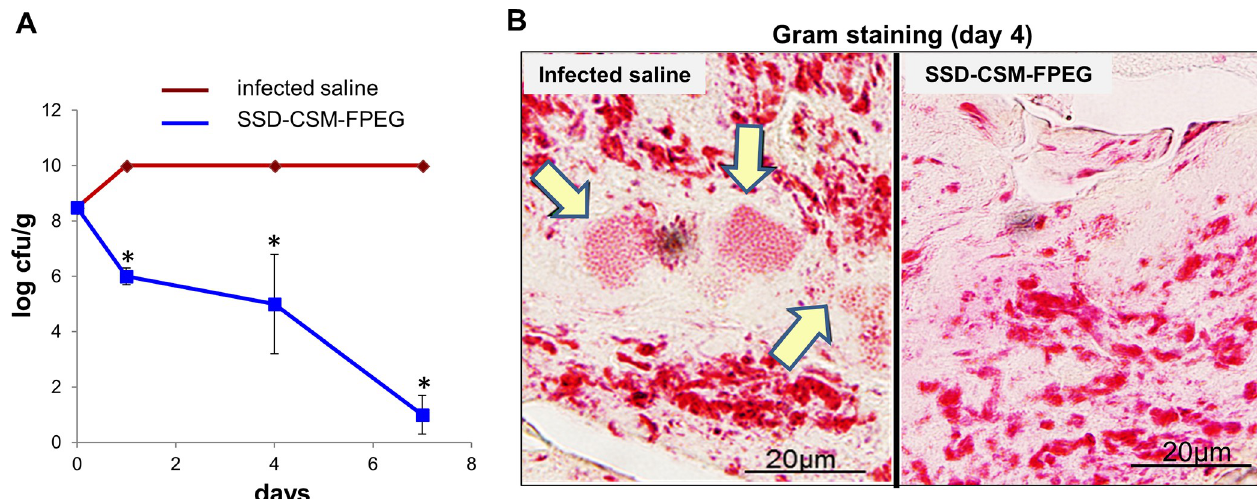
Fig 2. SSD-CSM-FPEG reduces bacterial load. (A) Bacterial growth kinetics upon treatment with SSD-CSM-FPEG. (B) Gram staining demonstrating presence of bacteria (indicated by arrows) in infected saline samples while absent in SSD-CSM-FPEG treated samples. ( n = 4, p < 0.05).